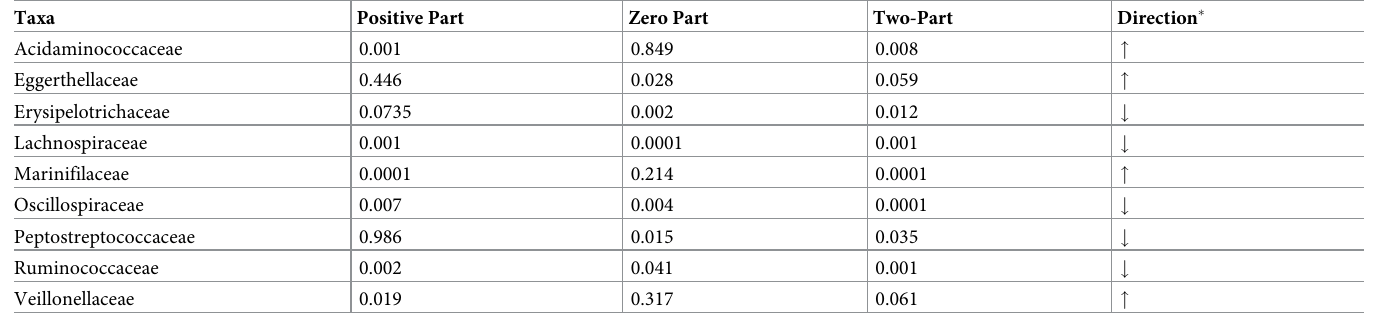
Table 6. Bacterial taxa associated with GWI adjusted for covariates at the family level. Taxa